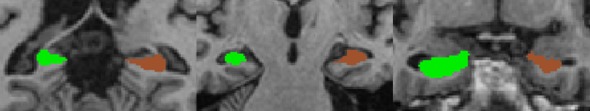
Hippocampus segmentation in reformatted pseudo coronal orientation.Brown colour is the left, green the right hippocampus. Left: posterior slice close to the crux of the fornix. Middle: one of the middle slices of the hippocampus. Right: anterior slice with hippocampus next to the amygdala.